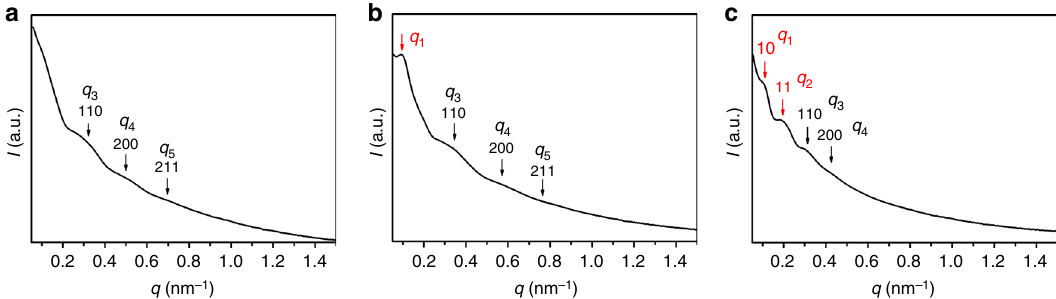
Fig. 5 Small-angle X-ray scattering (SAXS) patterns of PDMA 29 - b -P(St- alt -PFS) x block copolymer (BCP) particles. a x = 428, b x = 490, c x = 582. PDMA poly( N,N -dimethylacrylamide), St styrene, PFS penta fl uorostyrene